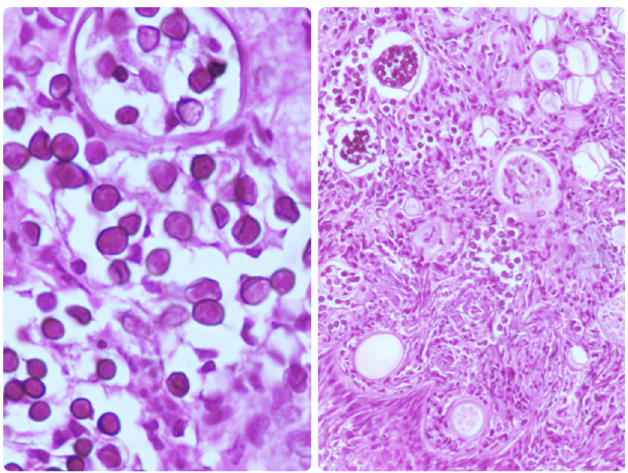
Fig. 4. Pictomicrograph ( (cid:1) 40, hematoxylin and eosin stained) showing sporangia on the left side and pictomicrograph ( (cid:1) 10, hematoxylin and eosin stained) showing chronic in fl ammatory in fi ltrates and giant cells with sporangia on the right